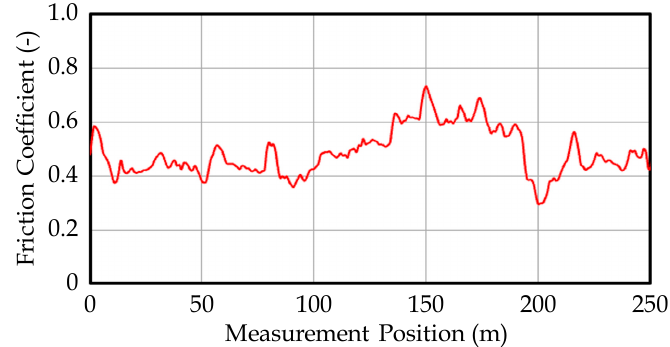
Figure 7. Measurement result for road friction with the Grip Tester.